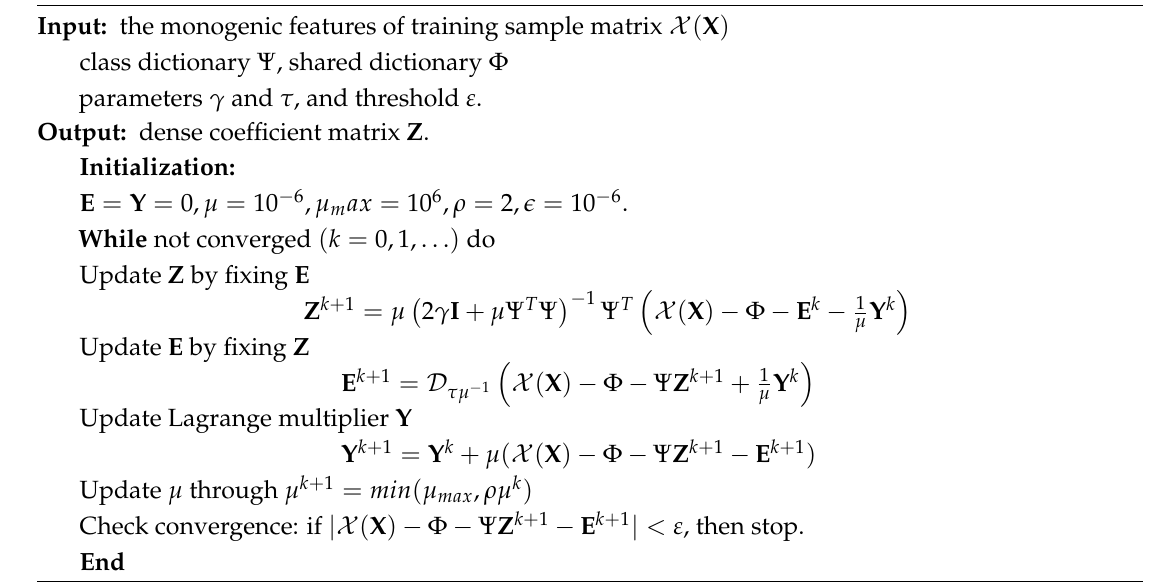
Algorithm 1 The procedure of solving the optimization problem in Equation